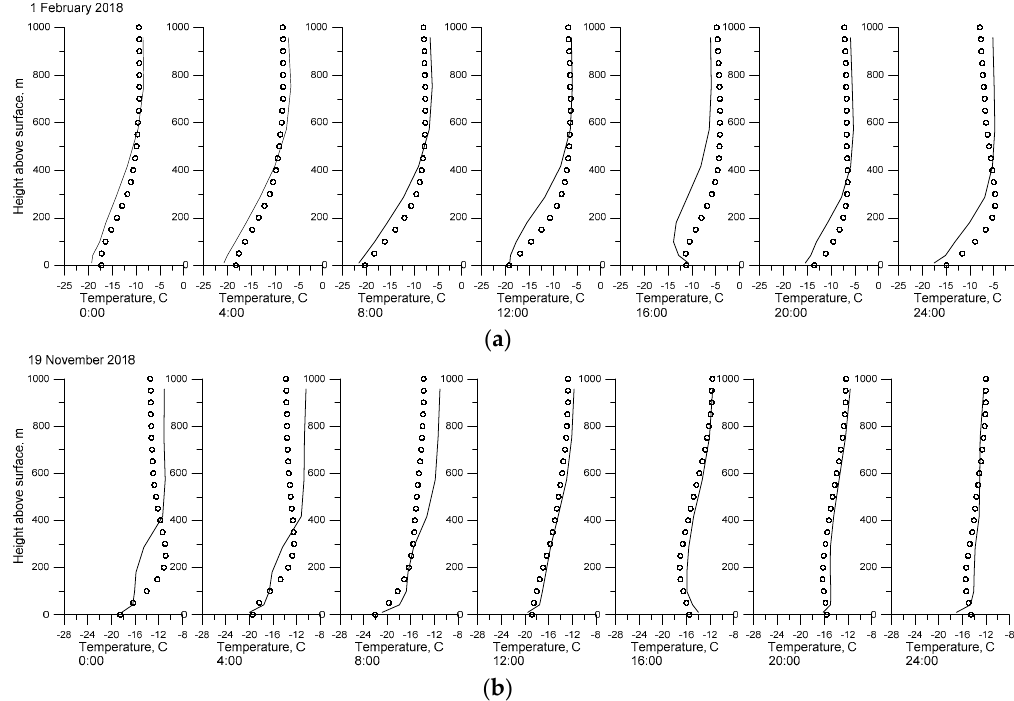
Figure 1. The extent of the computational domain is given in km.